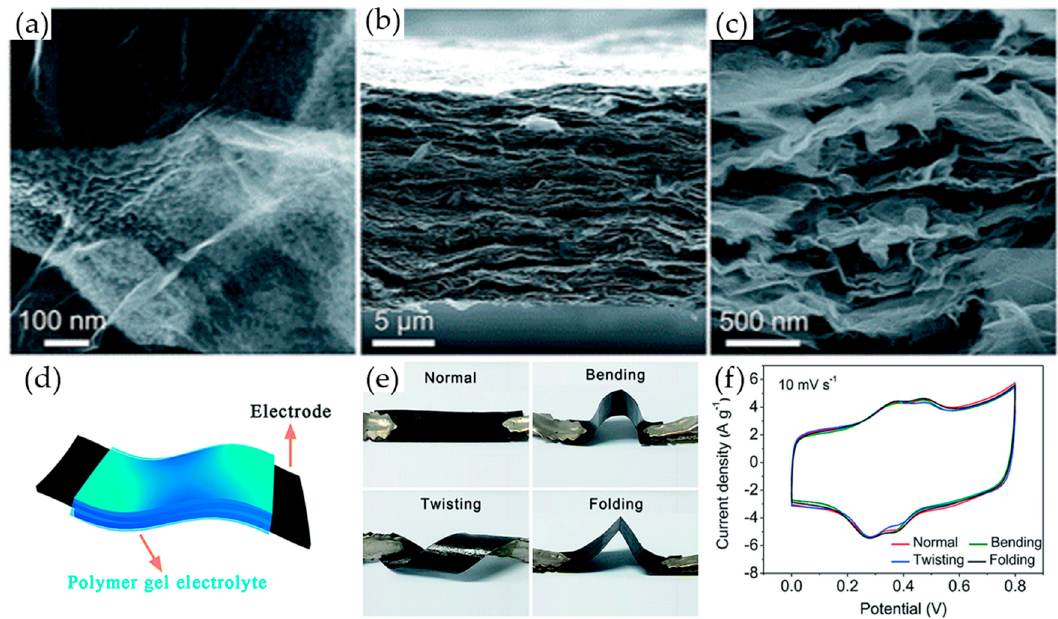
Figure 13. ( a ) SEM images of the 3DG/PANI composite; ( b ) Low- and ( c ) high-magnification SEM side view of the flexible 3D-G/PANI composite film; ( d ) Schematic illustration of a flexible 3D-G/PANI composite-based ASS; ( e ) Digital photographs of the flexible ASS under normal, bent, twisted and folded states; ( f ) CV curves of the flexible ASS under different deformation conditions. Reproduced with permission from [134]. The Royal Society of Chemistry (2017).